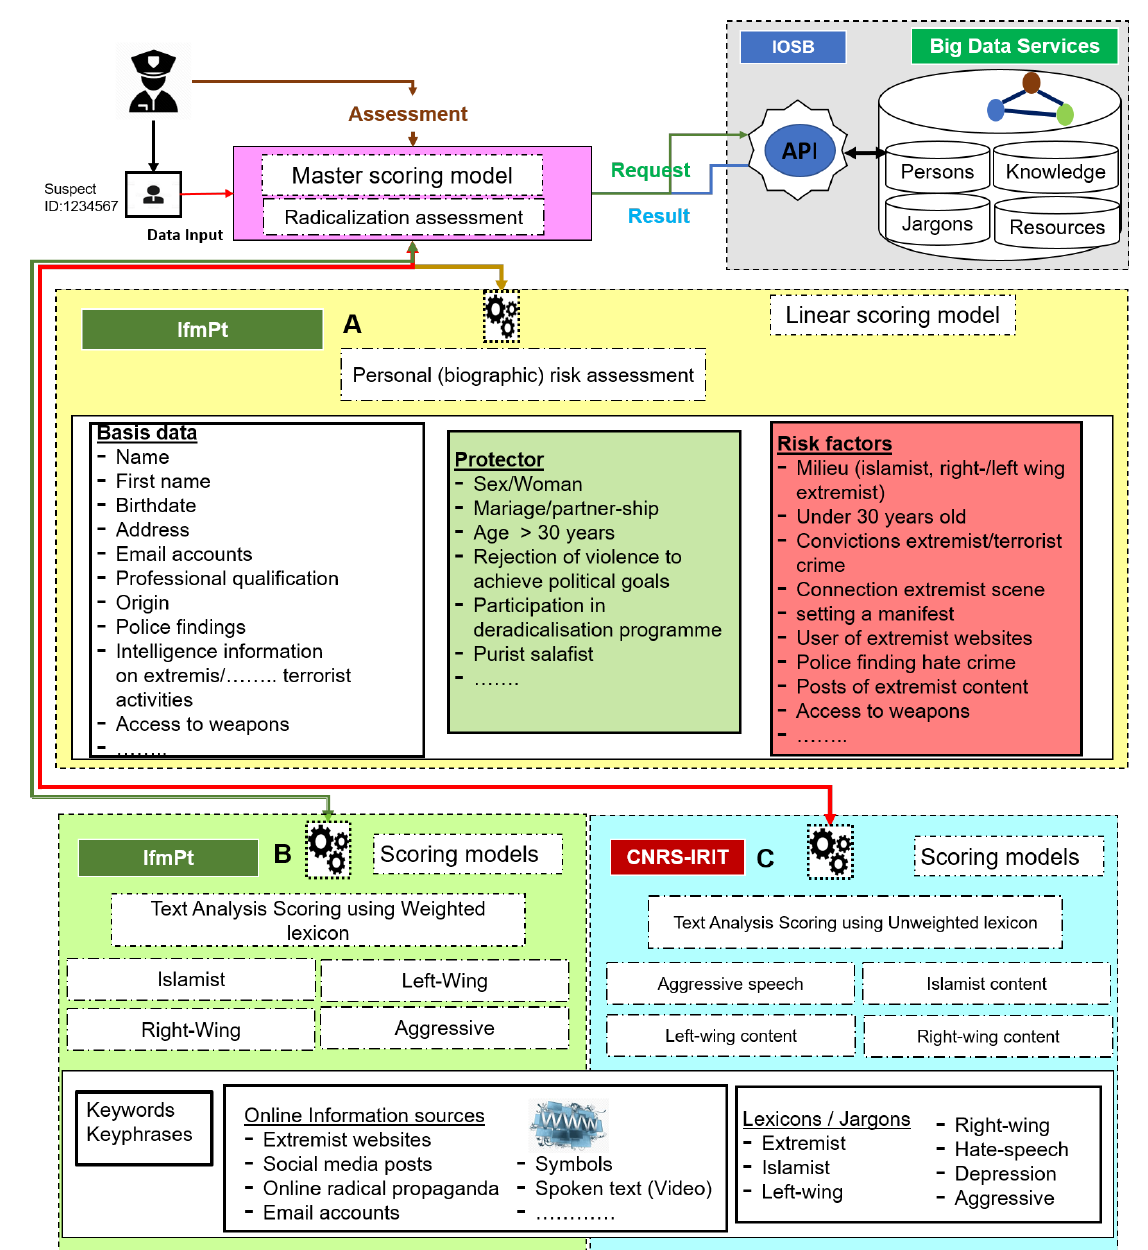
Figure 10. An architecture for helping LEAs is to assess radicalisation risk. In this schematic diagram, we can see the LEA interface, the Master scoring model, ( A ) Linear scoring model, ( B ) Text analysis with weighted lexicon model, ( C ) Text analysis with unweighted lexicon model, and the Knowledge-Base. Basically, ( A ) Linear scoring model computes the radicalisation score based on Person’s biographical risk/protector factors, ( B ) Text analysis with weighted lexicon model computes the radicalisation score from online information (e.g., social media posts) using a weighted lexicon (See Section 5.3), and ( C ) Text analysis with unweighted lexicon model computes the radicalisation score from online information using an unweighted lexicon (See Section 5.2). Using a user interface, an LEA chooses one or more people (or persons) and instructs the Master scoring model to compute the radicalisation score. The master model works as a coordinator among all the models. Firstly, the master model receives the command from LEA, retrieves the background and online data from the Knowledge-base, and interacts with the ( A – C ) modules to compute the respective radicalisation scores. Secondly, three models update the computed scores back to the Knowledge-base. Finally, the master model visualises the radicalisation score over time to help LEAs in assessment (see sub-section